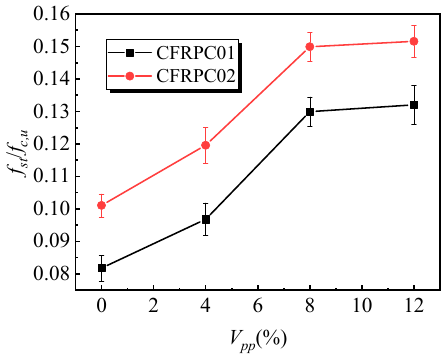
Figure 11. Effect of the polymer–cement ratio on the tension–compression ratio of specimens.